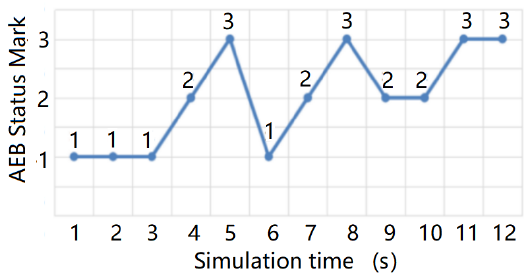
Figure 28. AEB state change with radar environmental clutter simulation data.